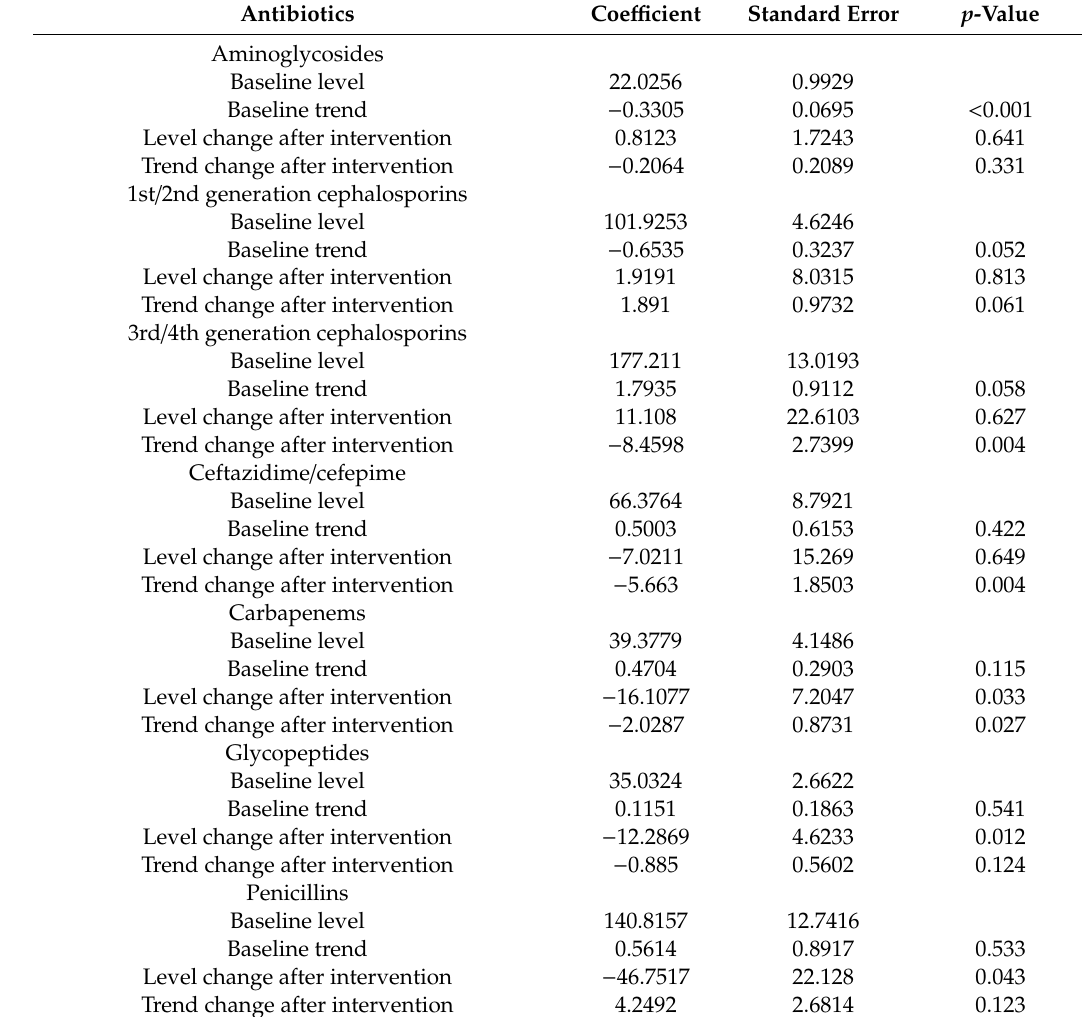
Table 2. Segmented regression model predicting monthly daily defined dose per 1000 patient-days in the